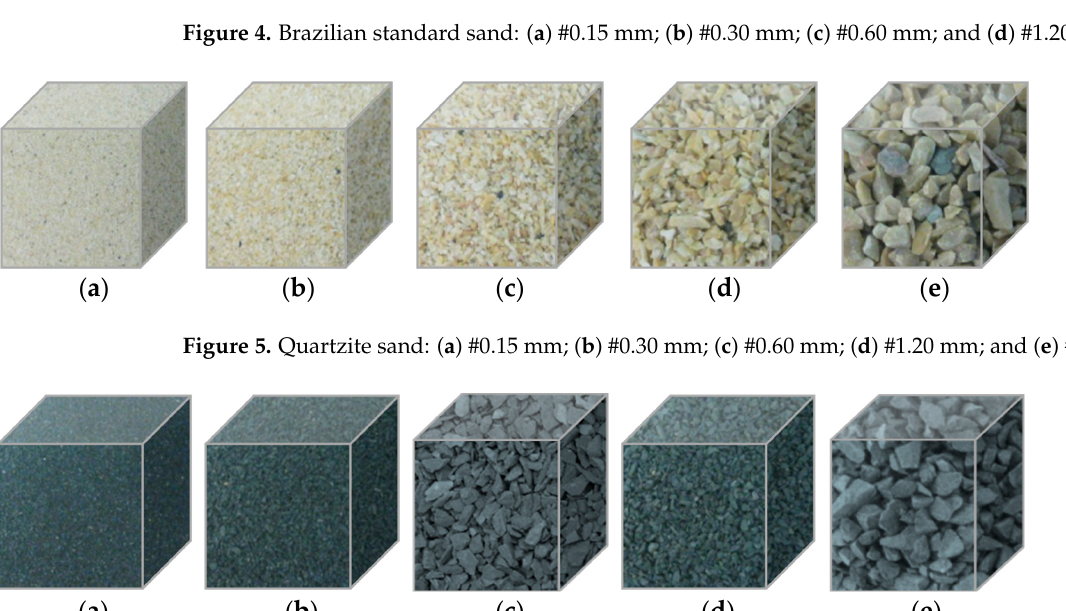
Figure 6. Basalt sand: ( a ) #0.15 mm; ( b ) #0.30 mm; ( c ) #0.60 mm; ( d ) #1.20 mm; and ( e ) #2.40 mm. The preliminary test to evaluate the reactivity of the aggregate indicated that the Brazilian standard sand is not reactive by ASR expandability. Differently, quartzite and basalt are reactive by ASR (Figure 7). As the objective is to evaluate the inhibitory potential of SCBA in combating ASR, only quartzite and basalt were used for this